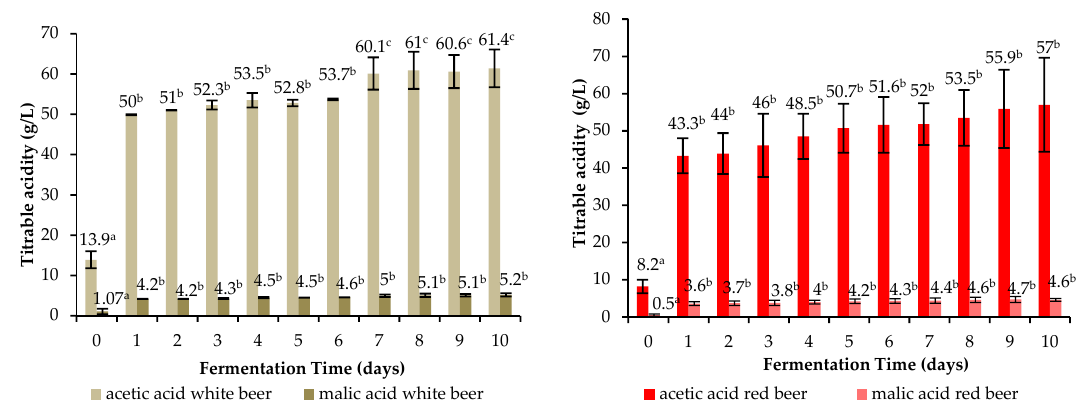
Figure 6. Evolution of titrable acidity during fermentation of the indigenous sorghum beers. Mean values ( n = 3 repetitions) preceded by at least one common letter (a, b, c) were not significantly different ( p < 0.05). Bars represent standard deviations.